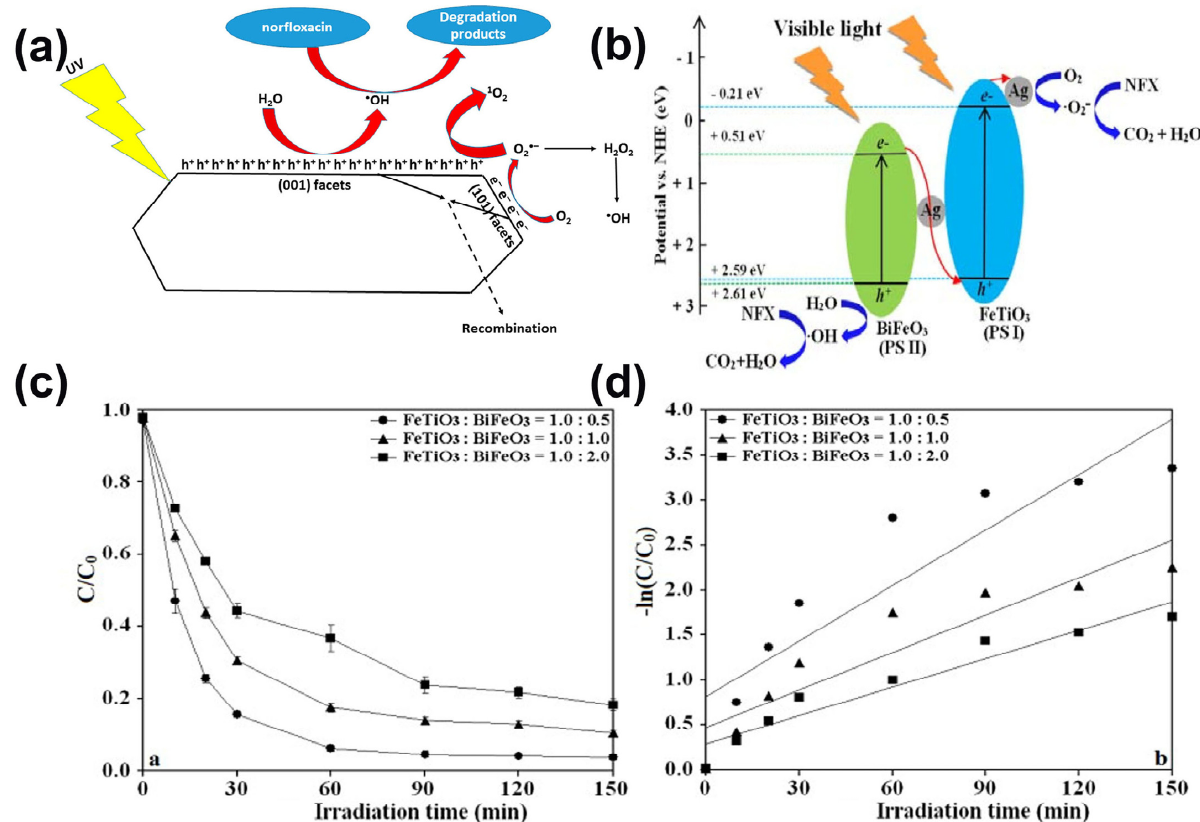
Figure 9. ( a ) Photocatalysis Mechanism of {001} Faceted TiO2/Ti Film. (Reproduced with permis- sion from [92], copyright 2016, American Chemical Society) ( b ) Possible mechanism diagram on Z-scheme Ag/FeTiO3/Ag/BiFeO3 system ( c ) Effect of mass ratio of FeTiO3 and BiFeO3 and ( d ) degradation reaction kinetics on photocatalytic activity (2.0 wt.% Ag; 5.0 mg/L norfloxacin; 1.0 g/L catalyst). (Reproduced with permission from [93], copyright 2018, Elsevier).